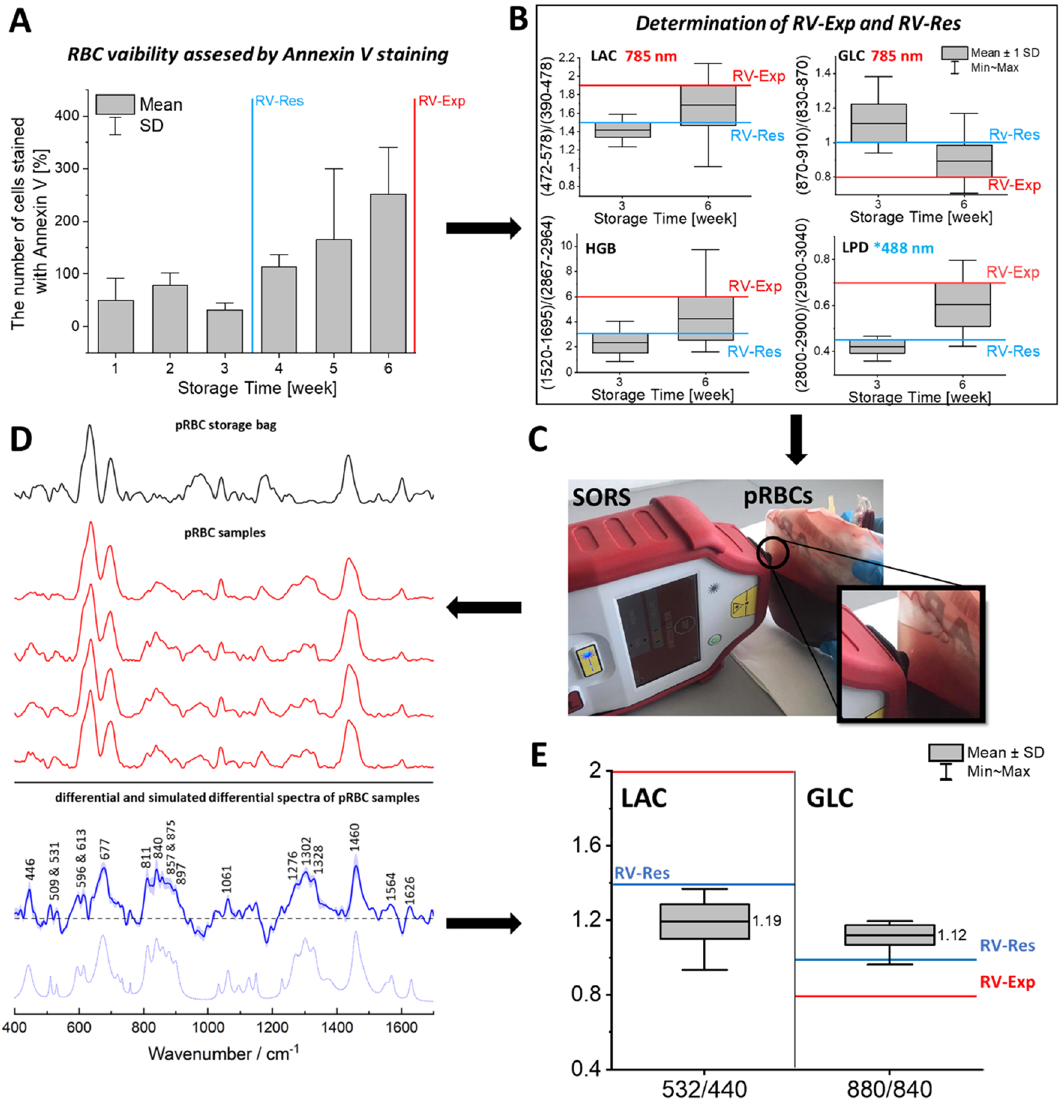
Determination of the RV-Res and RV-Exp values for LAC, GLC, HGB and LPD (N = 27) using RS; ( C ) SORS measurement carried out on SM via pRBCs bag; ( D ) The average SORS spectra of SM presented with the standard deviation (red solid line), differential spectrum (blue solid line) of the averaged SM spectra and the clean bag (black line) and simulated differential spectrum with the positive peaks only (blue scattered line). ( E ) Evaluation of pRBCs quality based on SORS measurements, based on the comparison of the obtained average value of LAC and GLC (presented as boxed charts) with RV-Res and RV-Exp values, indicating that